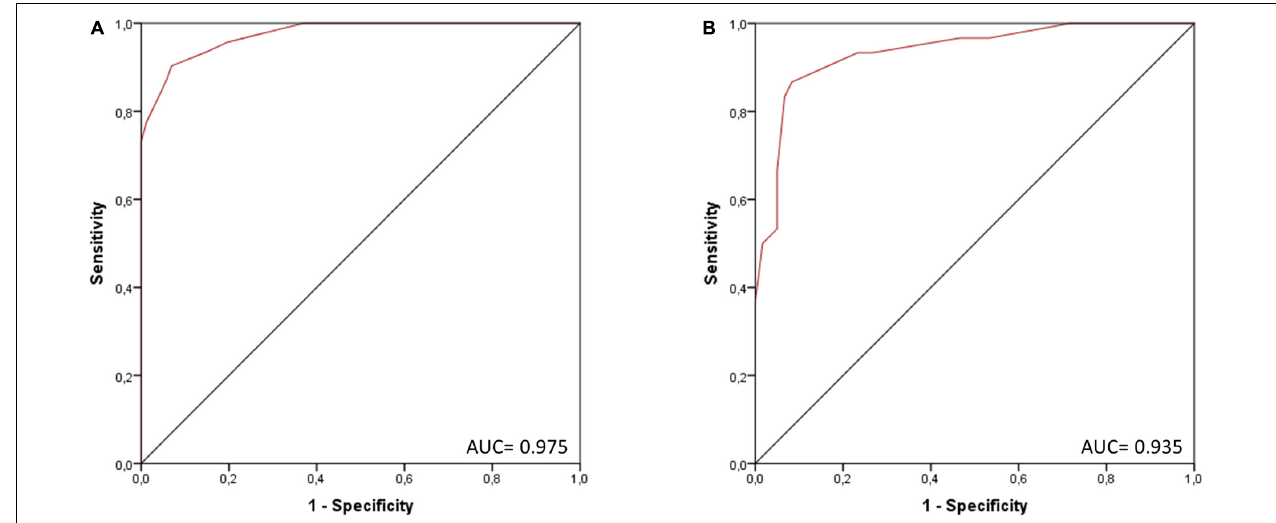
FIGURE 3 | ROC curve of the score for the presence of myocarditis in (A) the three-fourths cohort ( n = 266) and (B) the validation cohort (one-fourth of the total cohort, n = 90). AUC, area under the